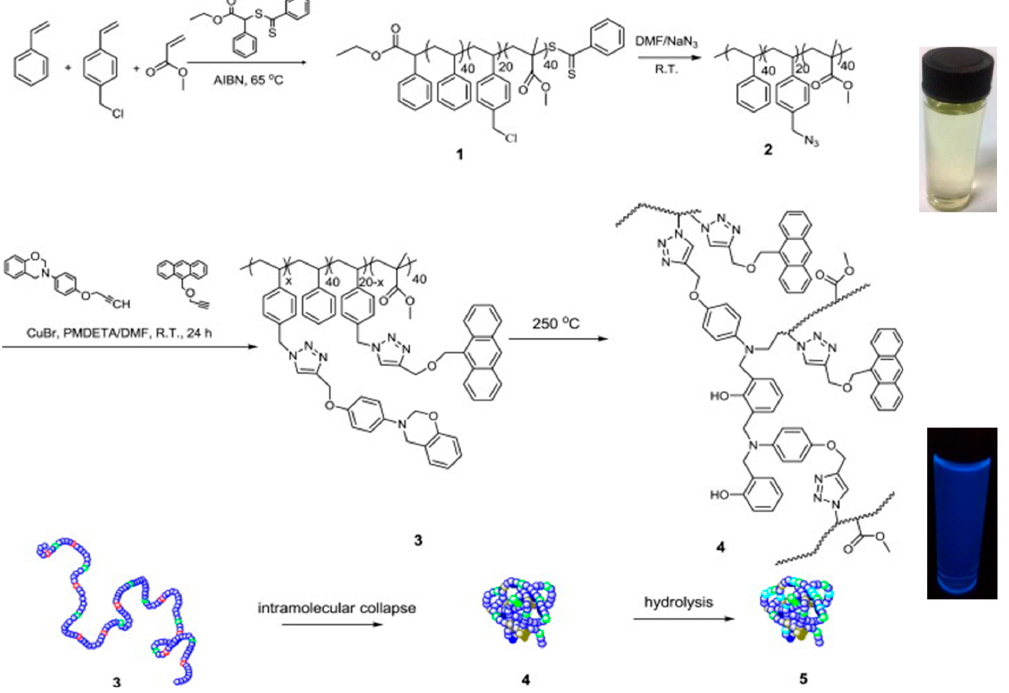
Figure 3. Synthesis of fluorescent SCNPs ( 4 ) via functionalization of the SCNP precursor terpolymer 2 with reactive (benzoxazine) and fluorescent (anthracene) groups ( 3 ) followed by intramolecular ring-opening polymerization of the benzoxazine